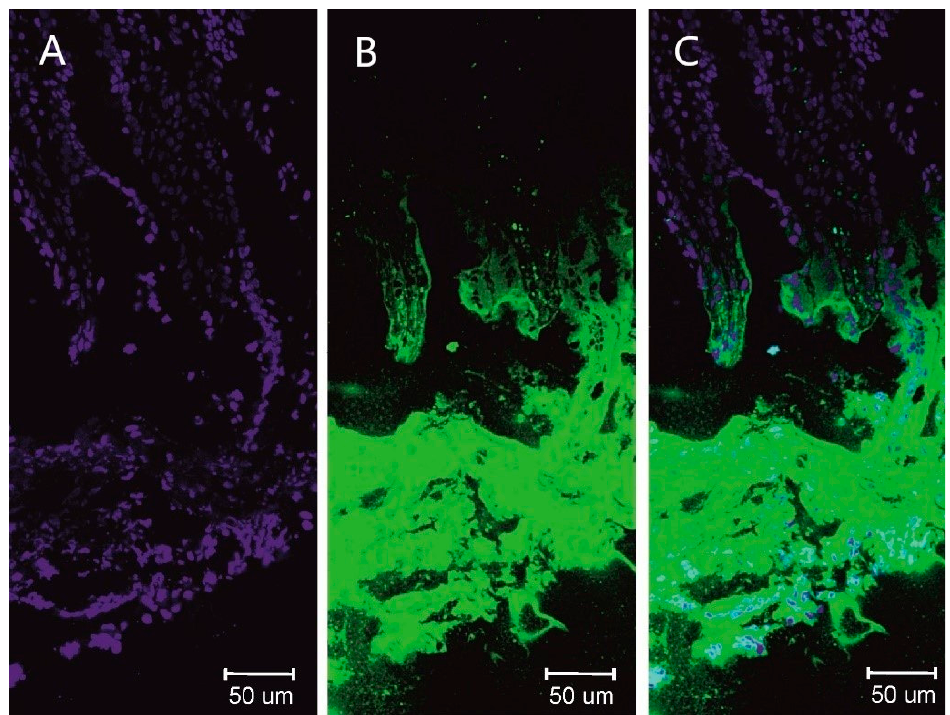
Figure 9. Cross-section of rabbit small intestine wall incubated with thymol/coumarin SES delivery system: ( A )—nuclei stained using DAPI, ( B )—fluorescent marker (coumarin), ( C )—merge of ( A , B ). I n summary, the performed 1 H- 1 H MAS NMR correlation experiments definitely